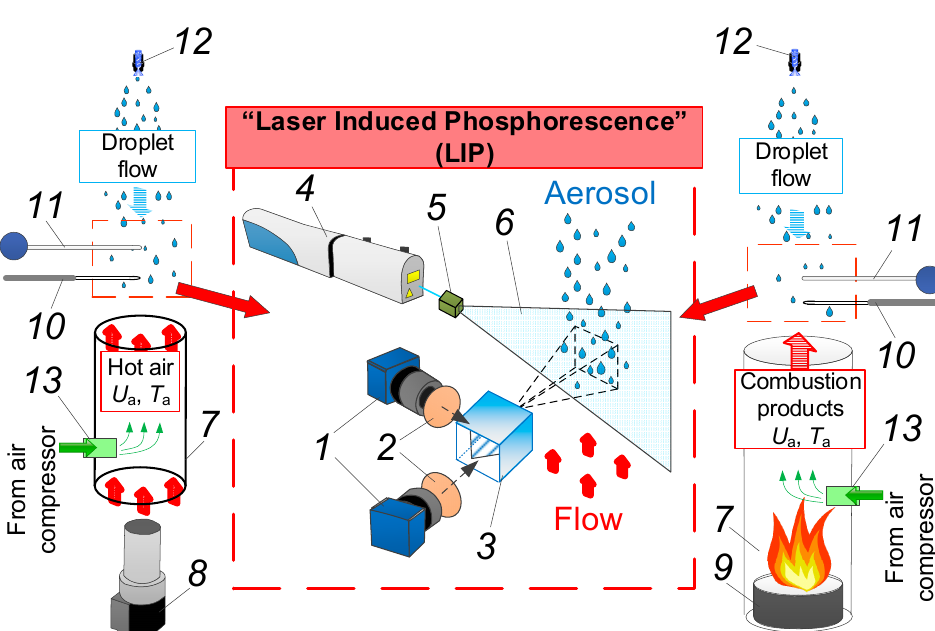
Figure 1. Scheme of experimental set-up: 1 —video camera; 2 —optical filter; 3 —beam splitter; 4 —Nd:YAG laser; 5 —laser optics; 6 —light sheet; 7 —quartz cylinder; 8 —air heater; 9 —burner; 10 —fast thermocouple; 11 —slow thermocouple; 12 —spraying nozzle; 13 —position of BAM:Eu particles.